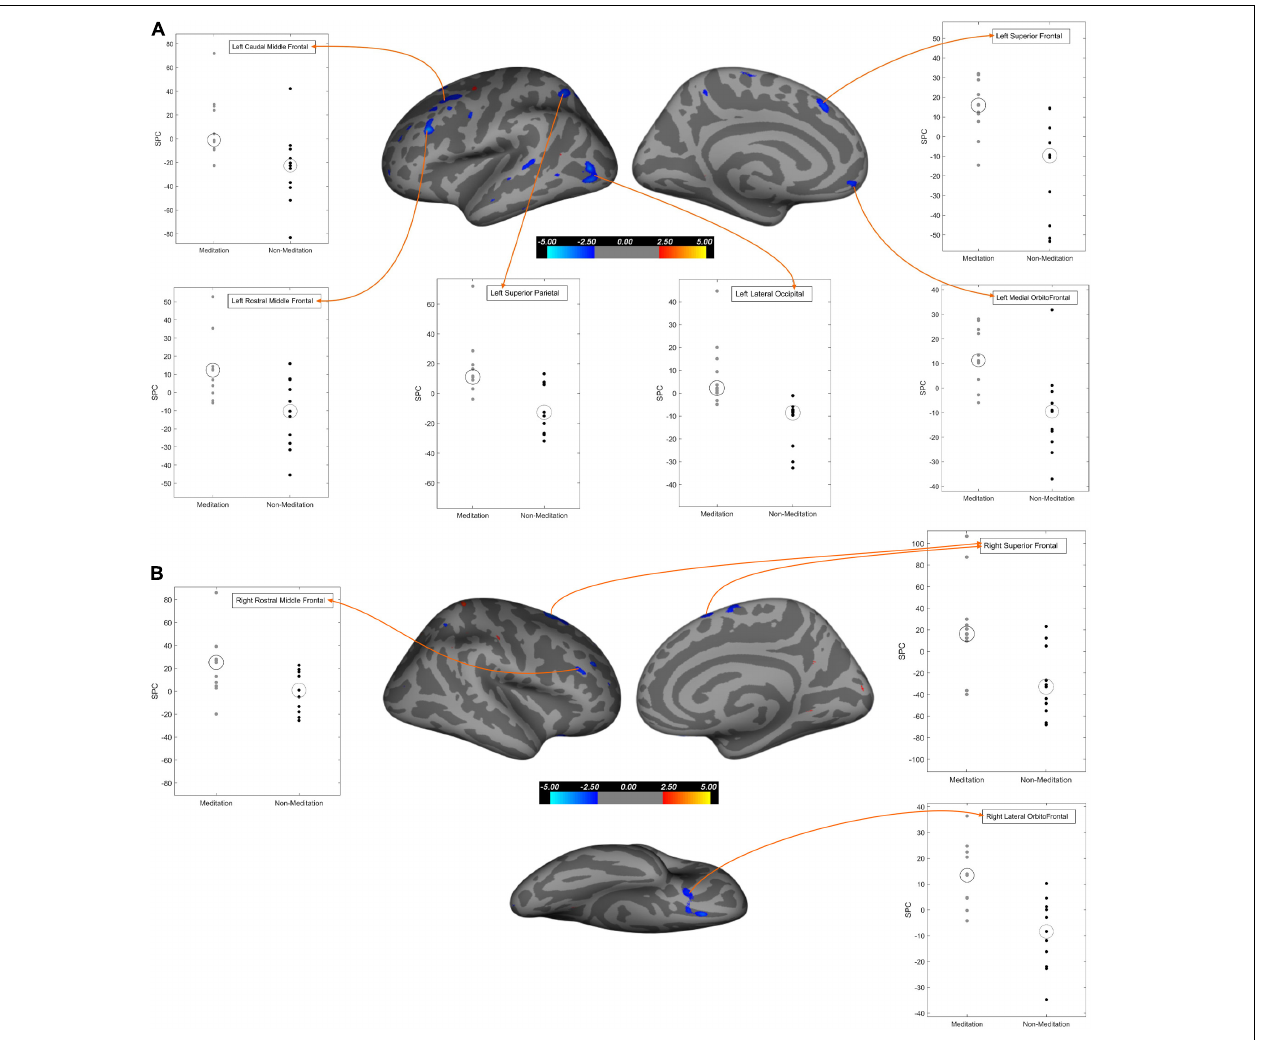
FIGURE 2 | Regions of gray matter volume that exhibit significant differences between meditation and non-meditation cohorts corrected for multiple comparisons, age, gender, and education. In all three different views (Lateral, medial, inferior) of brain surfaces, the blue clusters represent significantly higher SPC values while the red clusters represent significantly lesser SPC values in the meditation group compared to the non-meditation group. Graphs for significantly large cluster sizes are annotated on the inflated brain surface (see Table 6 for more details). (A) Left hemisphere; (B) Right